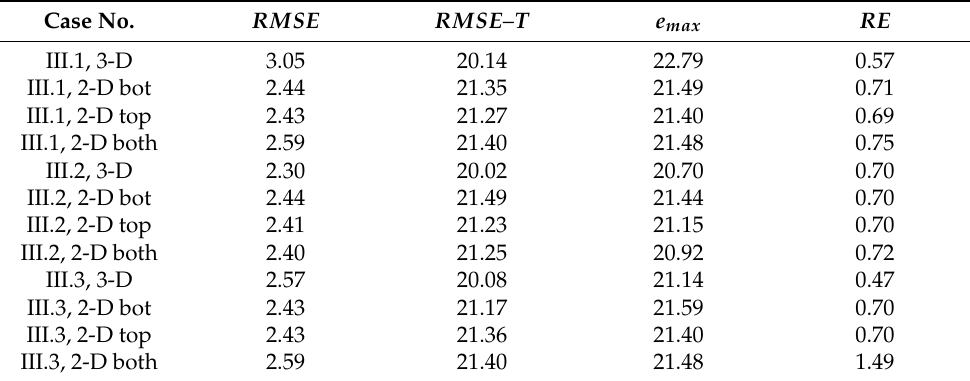
Figure 20. 2-D Reconstructions of (cid:60) ( ε r ) of Case III.3 for the x-y slice at 1.0 GHz using data from the: ( a ) bottom ring, ( b ) top ring, and ( c ) both rings. The headband of Figure 14 (with an increased distance between the array and the interface with air) is used to obtain the data. Table 5. Reconstruction Errors for the cases considered in Section 3.2.2.